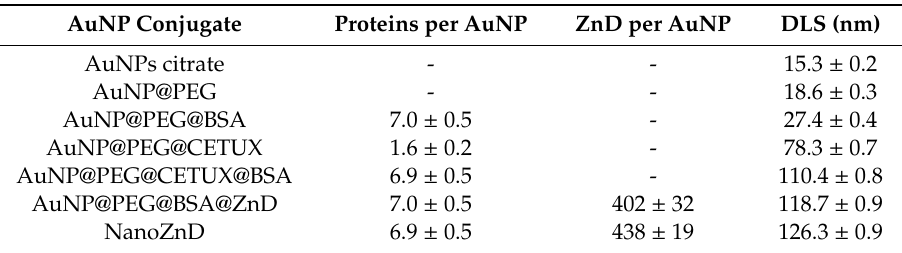
Figure 4. Physicochemical characterization of AuNP constructs. TEM image analysis of core naked AuNPs (scale bar, 50 nm) ( A ) evidencing an average diameter of 14 nm ( B ), UV / Vis spectra of AuNP constructs, ( C ) and surface plasmon resonance (SPR) peak variation upon each successful functionalization ( D ). Table 2. Nanoconjugate functionalization moieties and hydrodynamic size determination by dynamic light scattering (DLS). The di ff erent functional moieties and DLS size are discriminated (represented as means ± SEM of at least three independent experiments). The ratio of protein molecules and / or ZnD per nanoparticle in each nanoformulation is